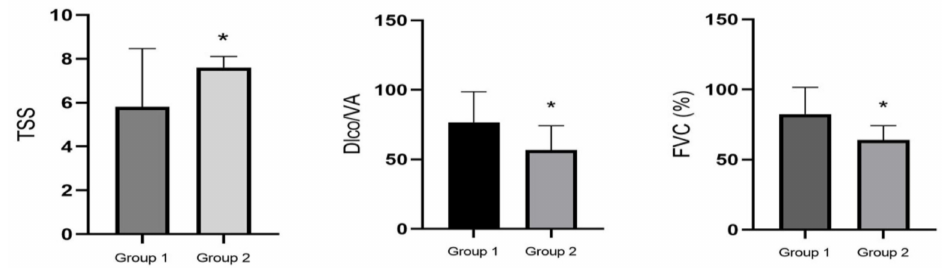
Figure 2. Pulmonary function test findings in patients with CTD-ILD. Group 1 (patients without bacterial colonization in broncho-alveolar lavage) or Group 2 (patients with bacterial colonization in broncho-alveolar lavage). * p < 0.05.